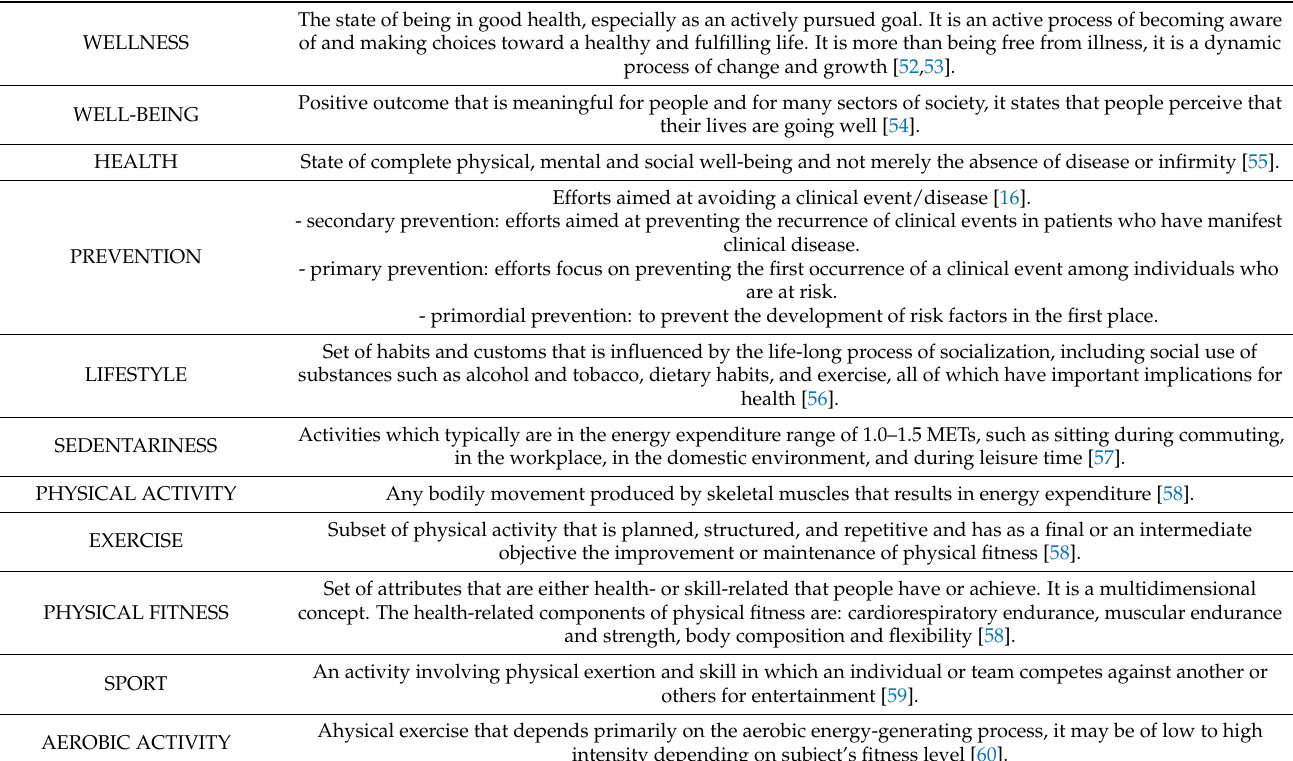
Table 1. Sport and exercise medicine: short